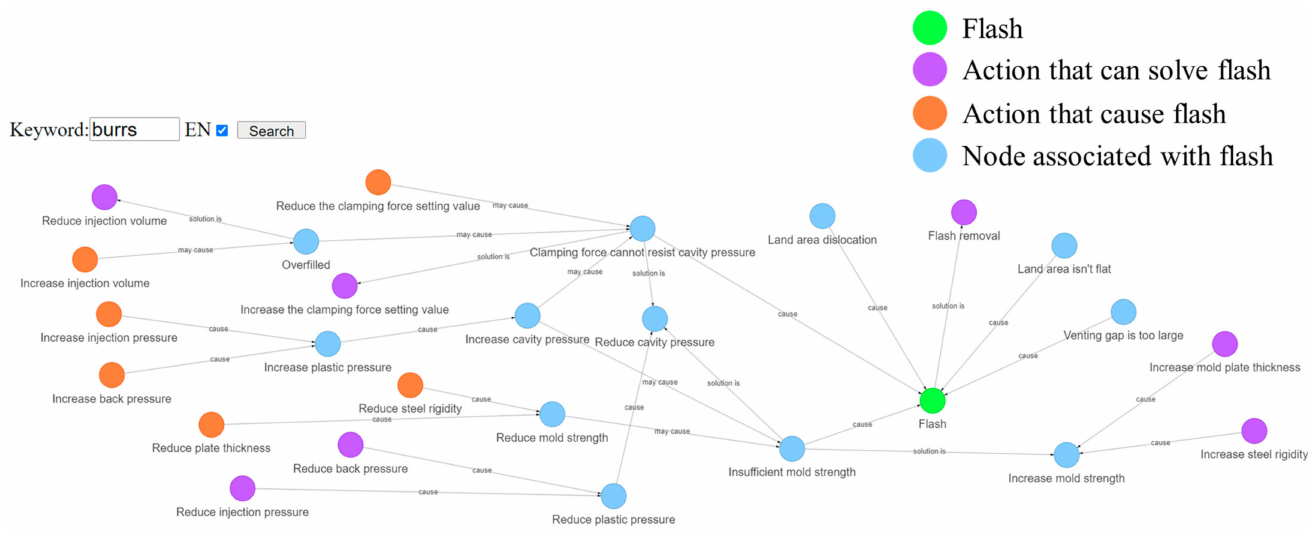
Figure 12. Problem node search result.